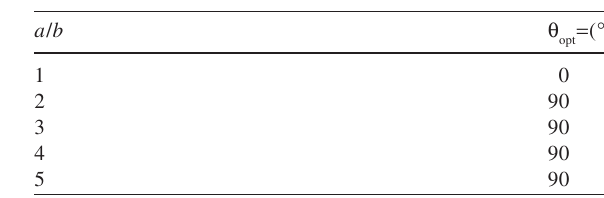
Table 11 Effect of plate aspect ratio on the optimum fi ber